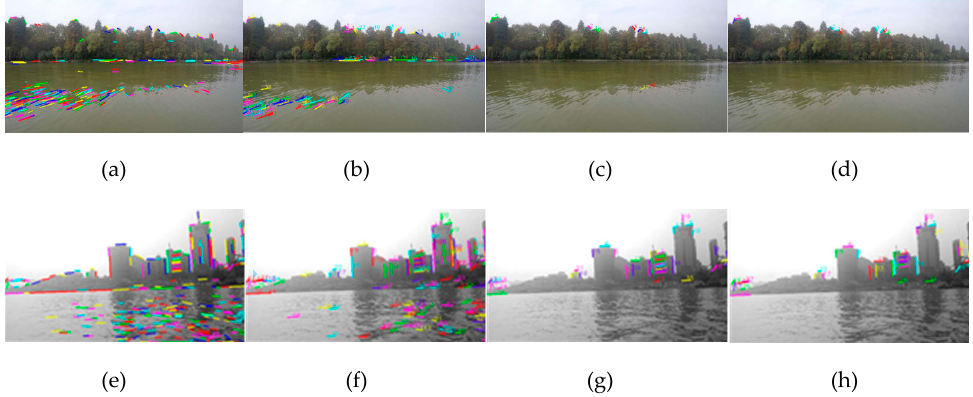
(t) Figure 15. The second group of the WSL detection experiments in the case of non-straight line: ( a )–( e ) and ( f )–( j ) are experiments in sunny days, the five columns from left to right correspond to line segment extraction, line segment matching, line segment pool rough selection, line segment pool fine selection and WSL generation. ( k )–( o ) and ( p )–( t ) are experiments in cloudy days. The second group of experiments is shown in Figure 15. The first and second rows correspond to sunny days, and the third and fourth rows correspond to cloudy days. The five columns from left to right correspond to line segment extraction, line segment matching, line segment pool rough selection, line segment pool fine selection and WSL generation. It can be seen from the Figure 15 that the water surface is relatively calm in the East Lake. In the